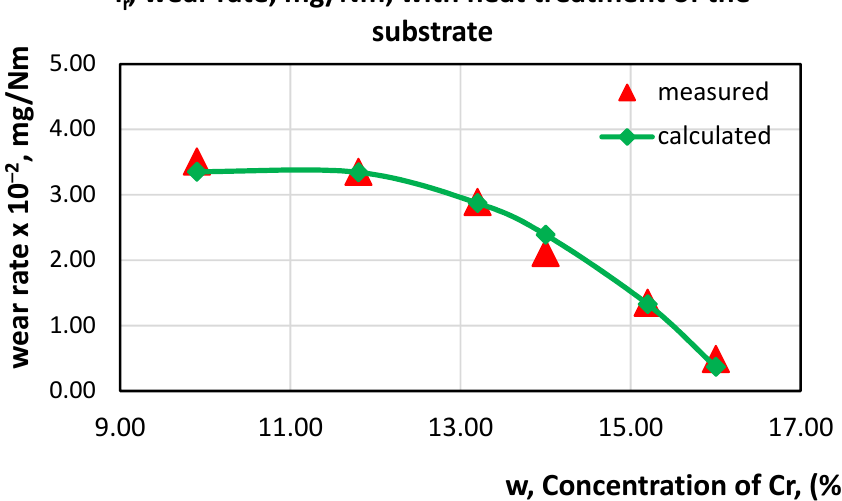
0.05 are smaller than 0.000032, i.e., they are smaller than 0.05, which means that the coef-